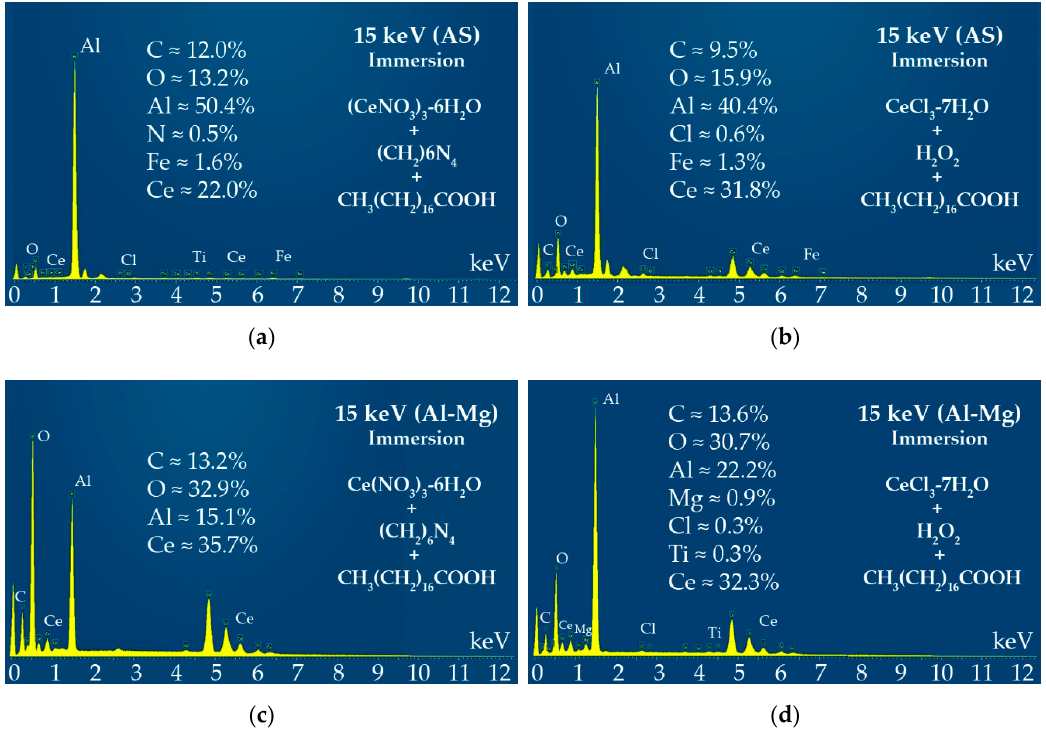
Figure 9. EDX spectra of ( a ) AS after immersion in cerium nitrate and stearic acid, ( b ) AS after immersion in cerium chloride and stearic acid, ( c ) Al-Mg after immersion in cerium nitrate and stearic acid, and ( d ) Al-Mg after immersion in cerium chloride and stearic